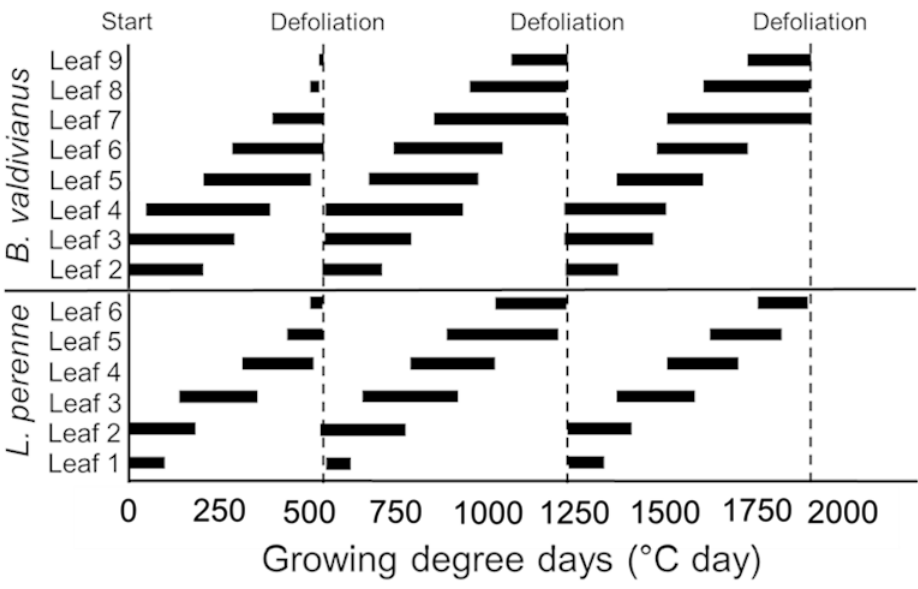
Figure 2. Scheme of the leaf expansion cycles based on GDD for the LS-5 treatment of B. valdivianus and the extra treatment of L. perenne based on the B. valdivianus (LS-5) defoliation frequency. Table 1. Plant parameters at the final harvest and the accumulation over several defoliations intervals under different defoliation frequencies for B. valdivianus defoliated by leaf stage development (LS). Final Harvest Results 1 Sum of All Defoliations 2